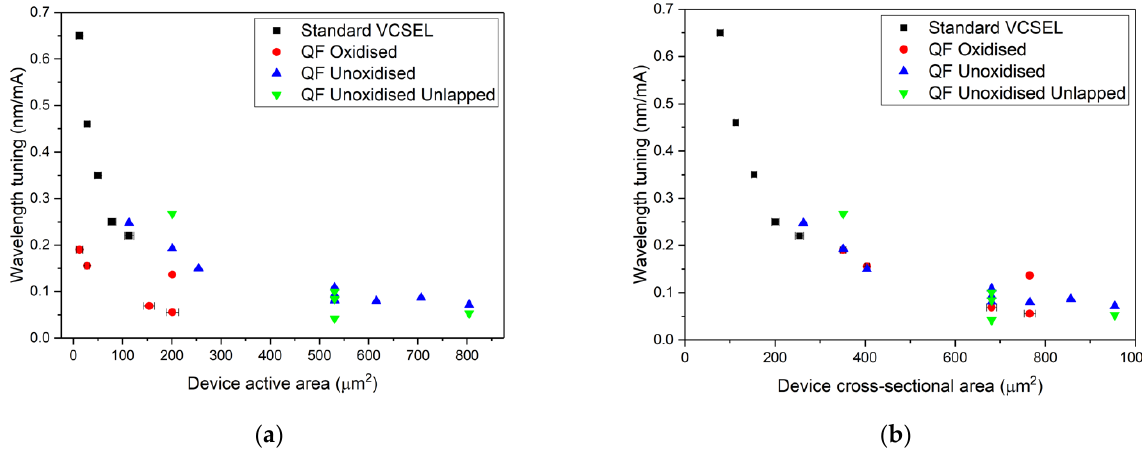
Figure 8. Tuning of the fundamental mode wavelength with injection current as a function of ( a ) device active area; ( b ) total device cross-sectional area, including the oxidised and bridge regions for the QF VCSELs.